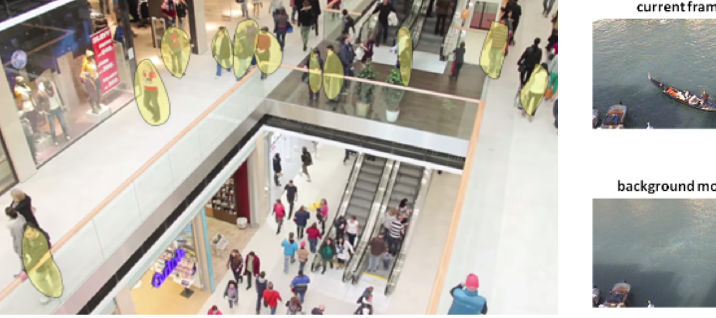
Figure 7: Example of video camera snapshot in the mall. Figure 8: Image subtraction to produce differences matrix.